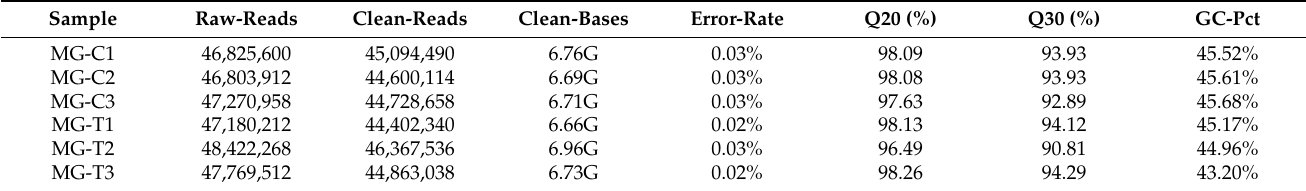
Table 1. Statistical analysis of the transcriptome sequence